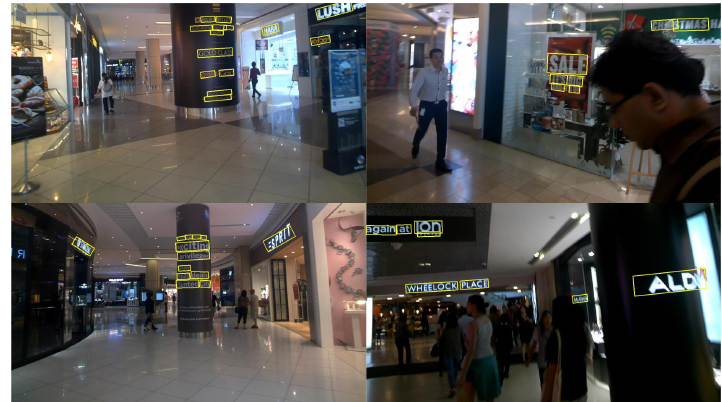
Figure 6. Prediction results with the ICDAR2015 dataset.